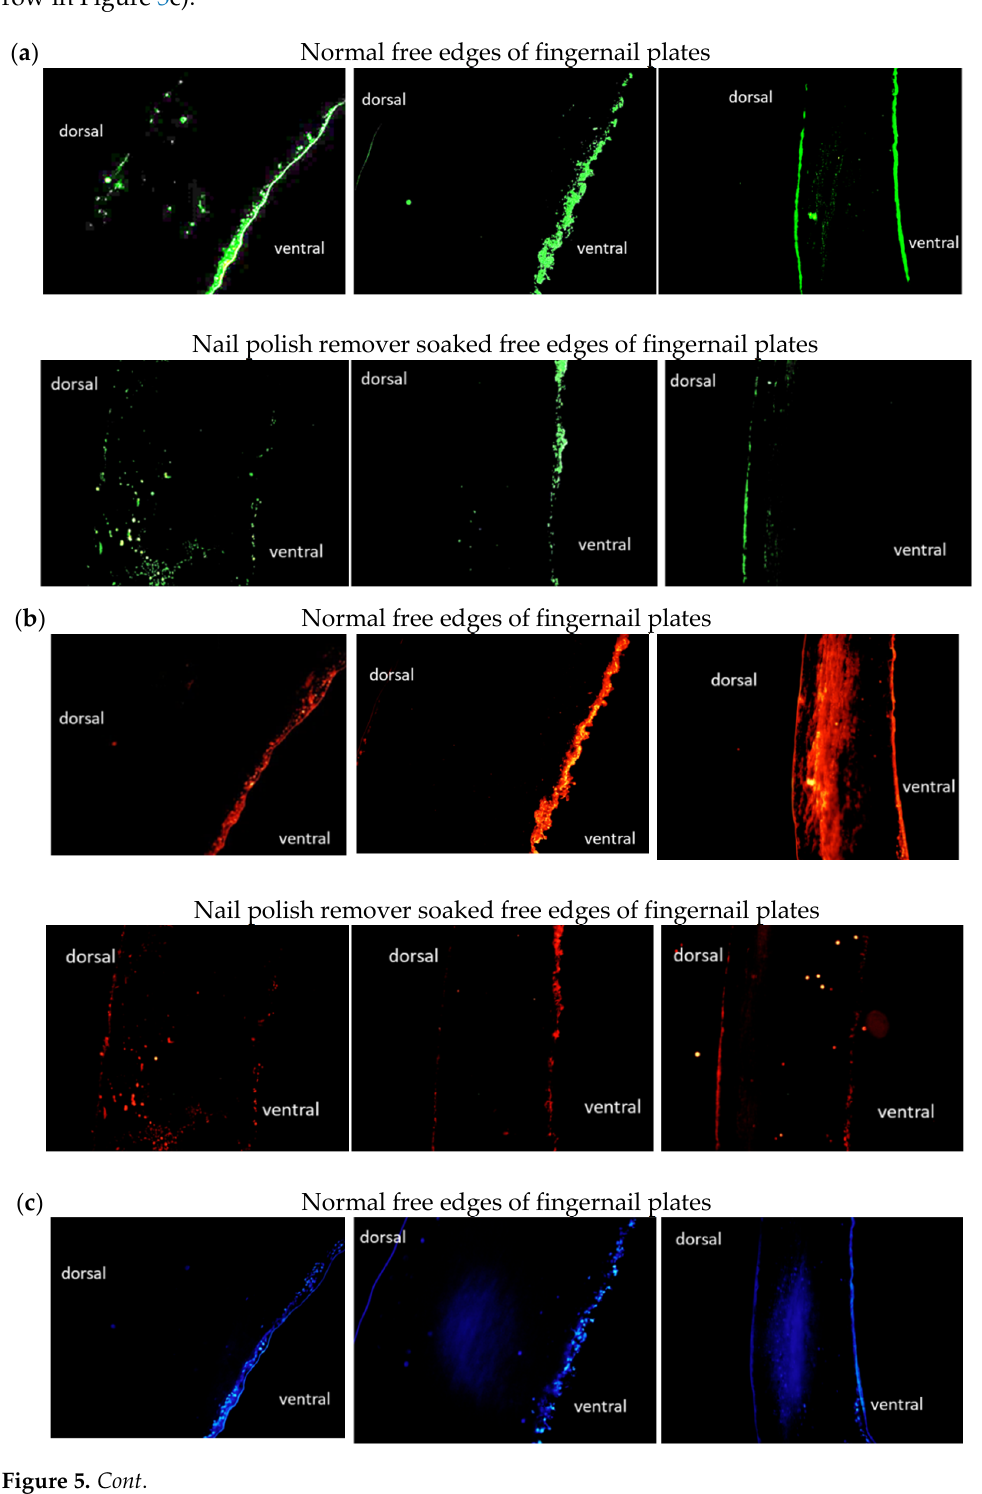
Figure 5. Cross-sectional anti-ceramide antibody staining and nuclear staining of healthy and nail polish remover soaked free edges of fingernail plates. ( a ): Cross-sectional anti-ceramide antibody staining of normal free edges of fingernail plates and nail polish remover soaked free edges of fin- gernail plates ( left : No. 1, middle : No. 2, right : No. 3). ( b ): Cross-sectional anti-glucosylceramide antibody staining of the normal free edges of fingernail plates and nail polish remover soaked free edges of fingernail plates ( left : No. 1, middle : No. 2, right : No. 3). ( c ): Nuclear staining of normal free edges of fingernail plates and nail polish remover soaked free edges of fingernail plates ( left : No. 1, middle : No. 2, right : No. 3). 4. Discussion Scanning electron microscopy (SEM) has revealed that, regardless of age, fingernails have a three-layered structure consisting of dorsal, middle, and ventral regions and that the surface is lined with keratinocytes similar to the cuticle of a hair [1]. However, it has been reported that, with aging, the dorsal region becomes damaged, and the degree of cuticle-like substance detachment increases [13]. It was reported that there was no signif- icant correlation between the nailfold thickness and the water evaporation from the nail plate [14]. However, Murdan et al. found an inverse linear relationship between tran- sonychial water loss (TOWL) and nail thickness [15]. The factors that cause changes in